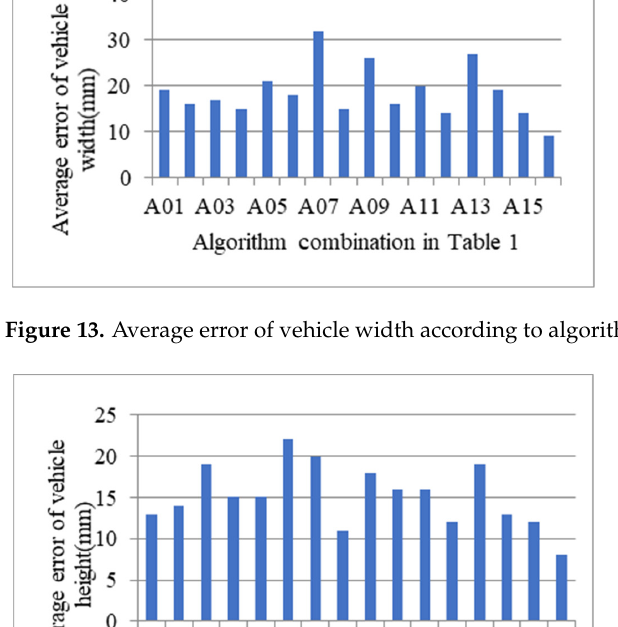
Figure 15. Standard deviation of vehicle width according to algorithm combination in Table 1.